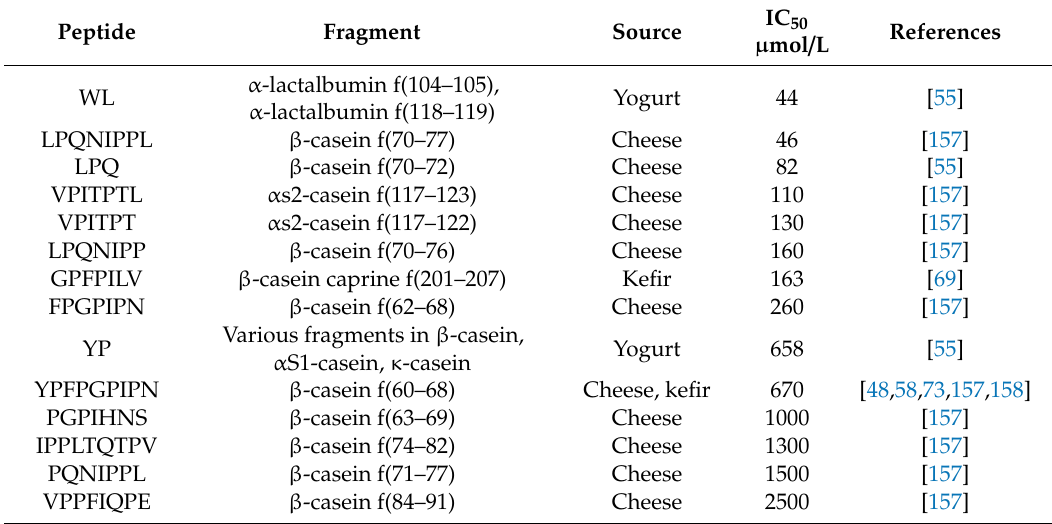
Table 4. Peptides with in vitro dipeptidyl-peptidase-IV (DPP-IV) inhibitory activity identified in commercial fermented dairy products 1